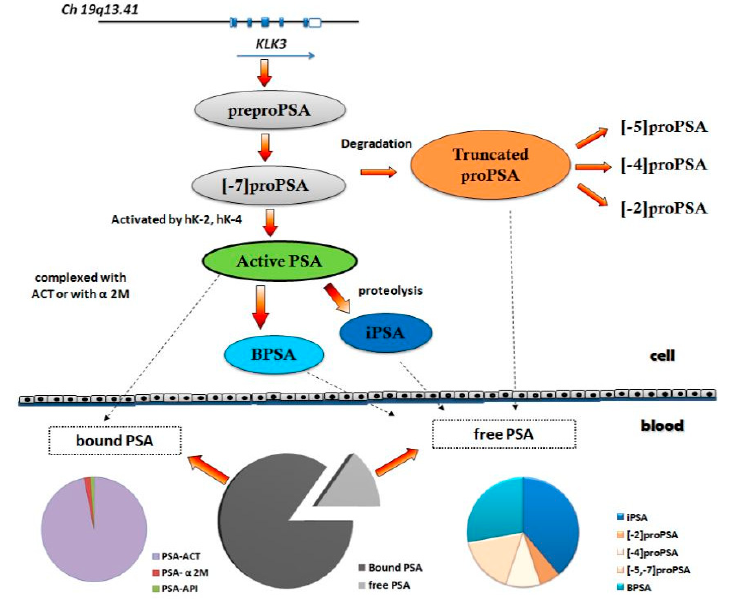
Figure 1. Molecular forms of PSA. The arrows with dashed line mean the forms of PSA that go from the cell to the blood. PSA: prostate specific antigen, BPSA: benign PSA, iPSA: intact PSA, PSA-ACT: Alpha 1-antichymotrypsin-PSA, PSA-API: alpha1-trypsin inhibitor PSA, PSA-A2M: alpha 2 macroglobulin, hK-2: human kallicrein 2, hk-4: human kallicrein 4.